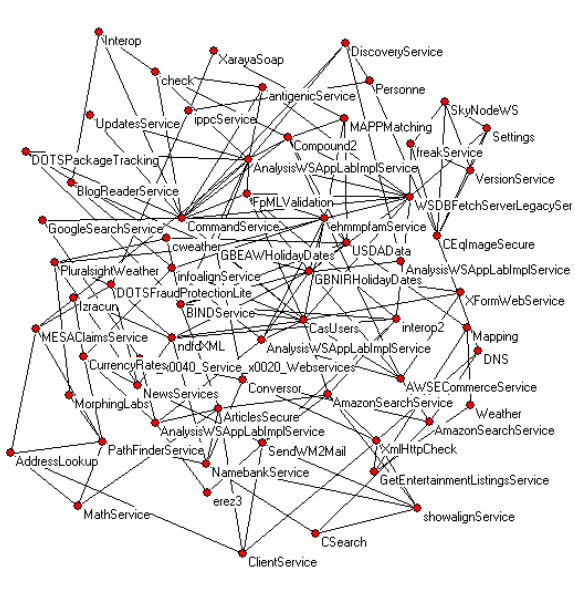
Fig. 3. The part of the resulting